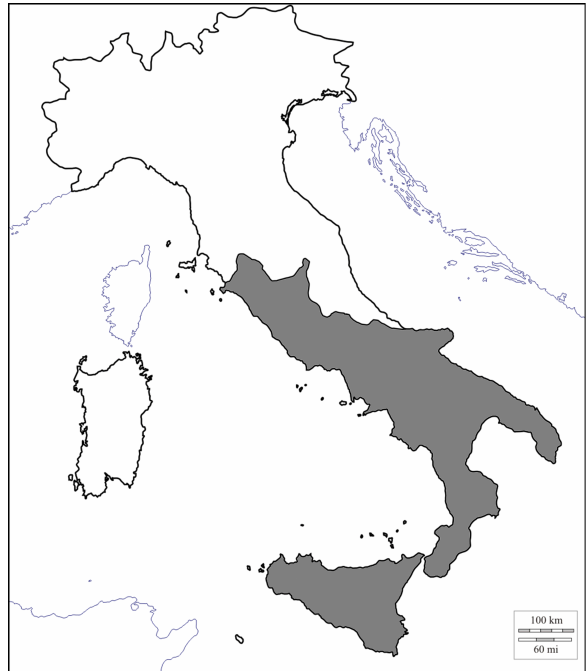
Figure 1. Distribution map of Lepus corsicanus (redrawn from Angelici and Spagnesi